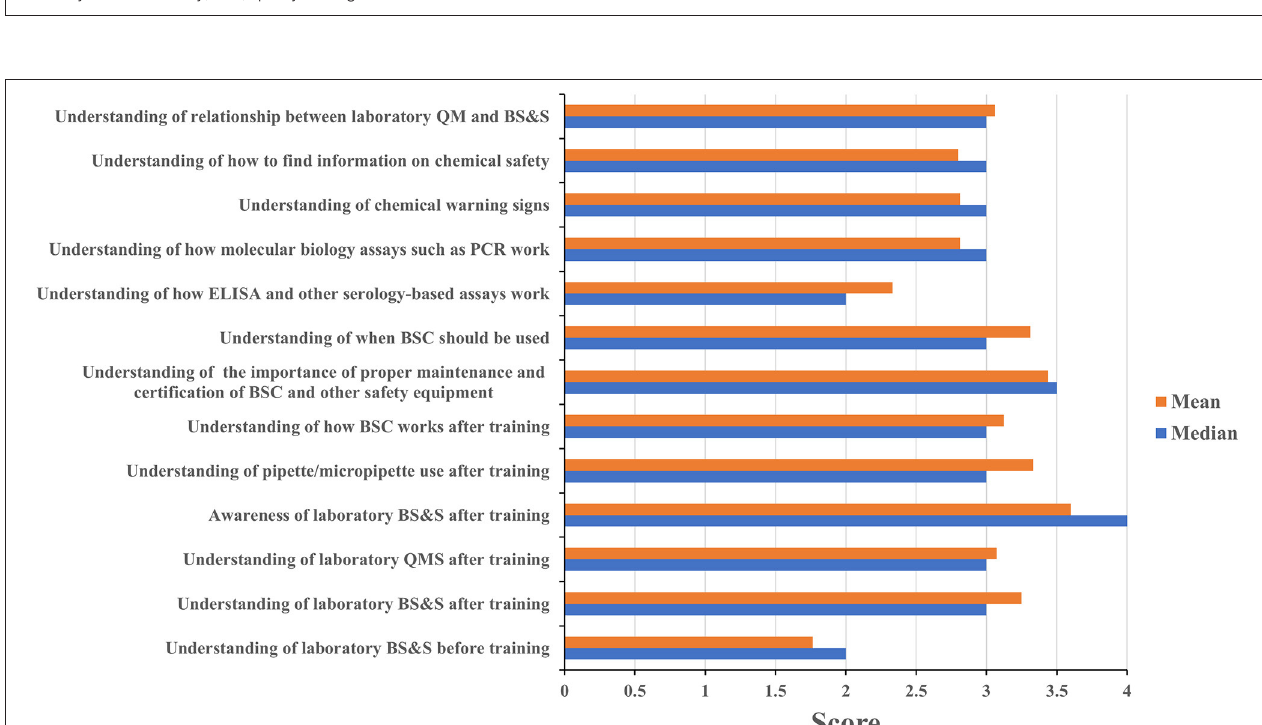
FIGURE 4 | Staff training impact. Questionnaires were designed for self-evaluation of staff participant’s knowledge impact on their professional activities. Trainees were asked to score 1 to 4 with 1 being the least score and 4 the highest. The mean and median were then calculated. MoH, ministry of health; BS&S, biosafety and biosecurity; QM, quality management.